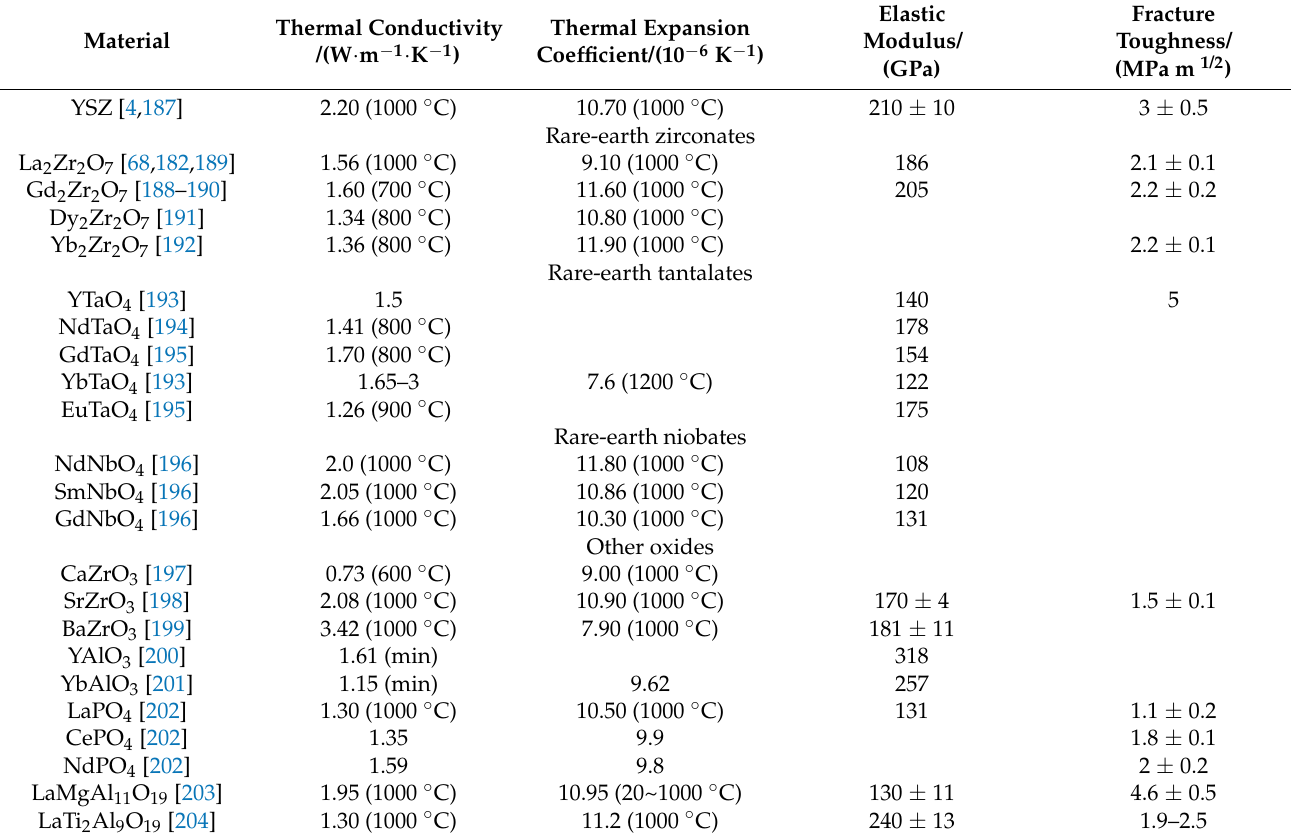
Table 1. Thermal physical properties of potential TC